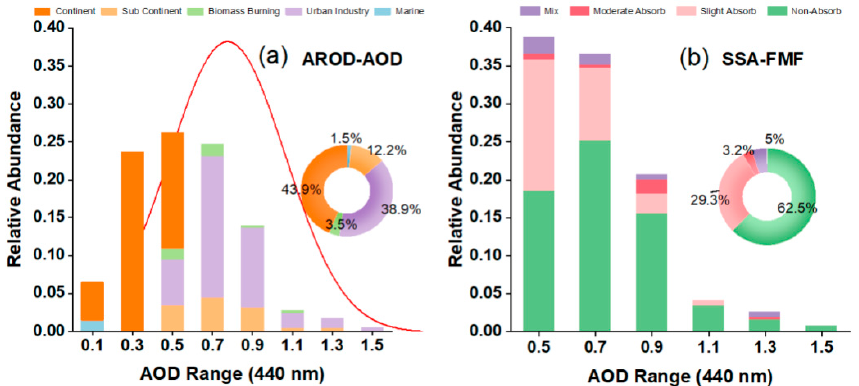
Figure 5. Aerosol typing results based on aerosol optical depth (AOD)–AROT ( a ) and fine-mode fraction (FMF)–SSA ( b ). The occurrence frequency of each type is presented according to the AOD range bins. Note that AOP observations with AOD (440 nm) less than 0.4 are screened in FMF–SSA aerosol typing results ( b ) for quality assurance.